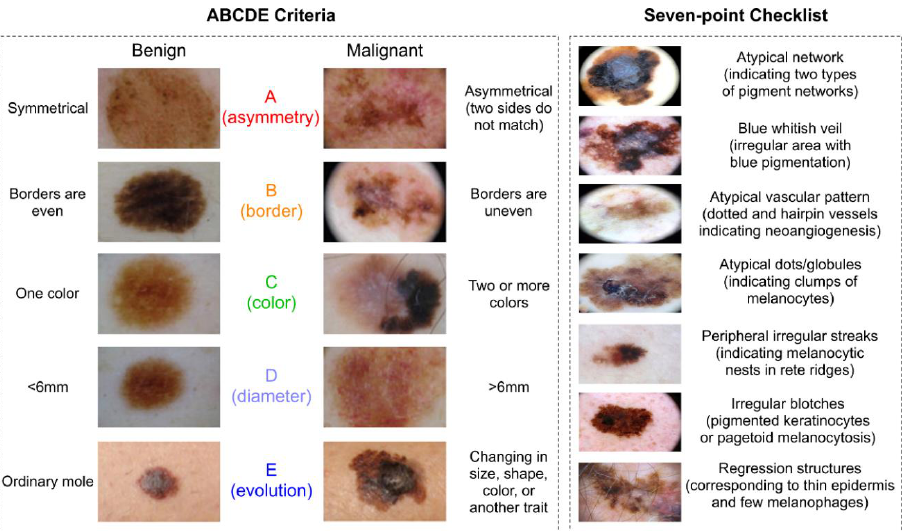
Figure 6. Visual melanoma biomarkers: ABCDE criteria of asymmetry, border irregularity, color variation, diameter (>6 mm), and evolution, reproduced from [37] . Seven-point checklist images (1st